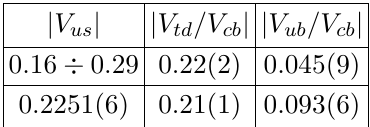
Table 2 . U(2) predictions for s d = 0 (second line) and current experimental values (third line). With (cid:18) d 6 = 0 all these relations, in particular the one for V ub =V cb , are brought to precise agreement with